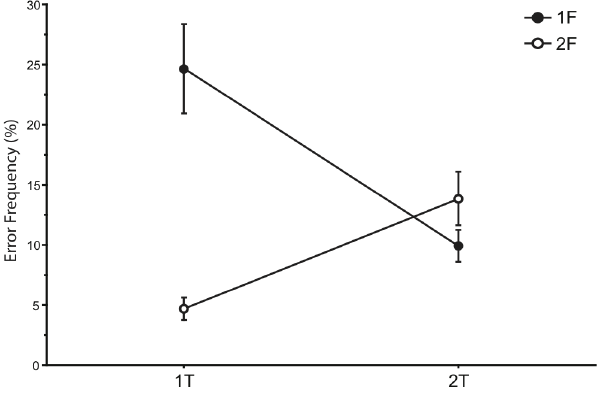
Figure 2. Error frequency in the incongruent direction condition at each level of response representation: one-finger response represented in the target (1T) and two-finger responses represented in the target (2T), as well as one-finger response represented in the flanker (1F) and two-finger response represented in the flanker (2F). Error frequency increased when the representation of the responses in the target and flanker were of the same size (1F/1T and 2F/2T) compared to when the representation of these responses was different (1F/2T and 2F/1T). The figure only includes errors where the erring response matched the response represented by the flanker stimulus. Error bars represent 1 SD.